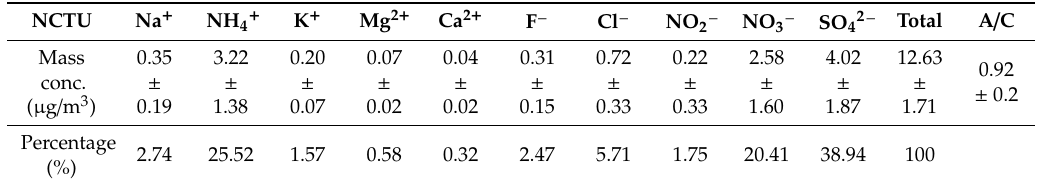
Table 1. Mass concentration and percent mass of the particles smaller than 2.5 µm in diameter (PM 2.5 ) water-soluble inorganic species measured by the PDS.